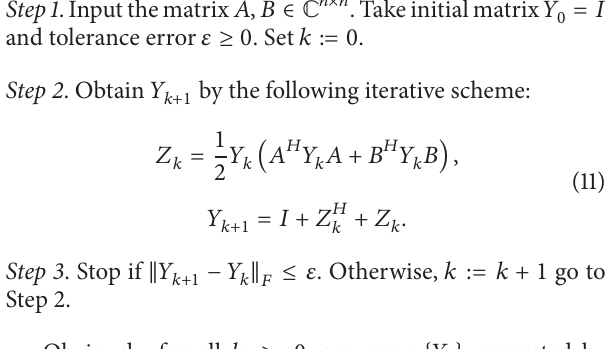
Algorithm 1 (an inversion-free iterative algorithm for